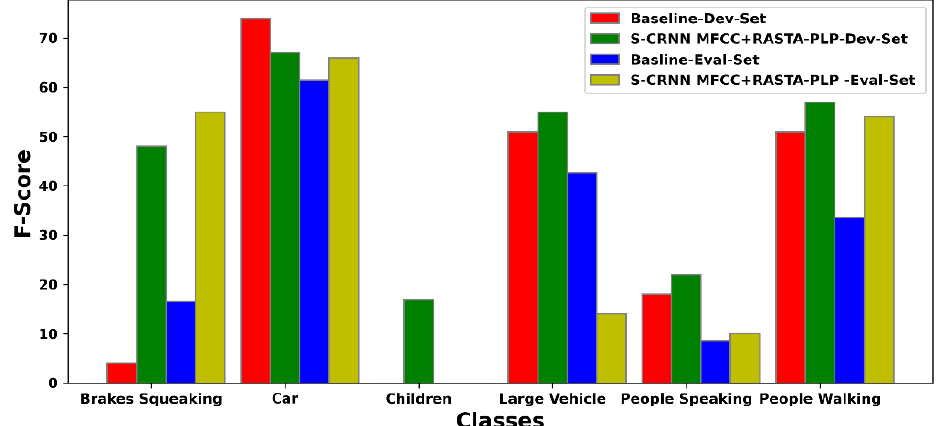
Figure 10. F1-score comparison using S-CRNN Classifier.